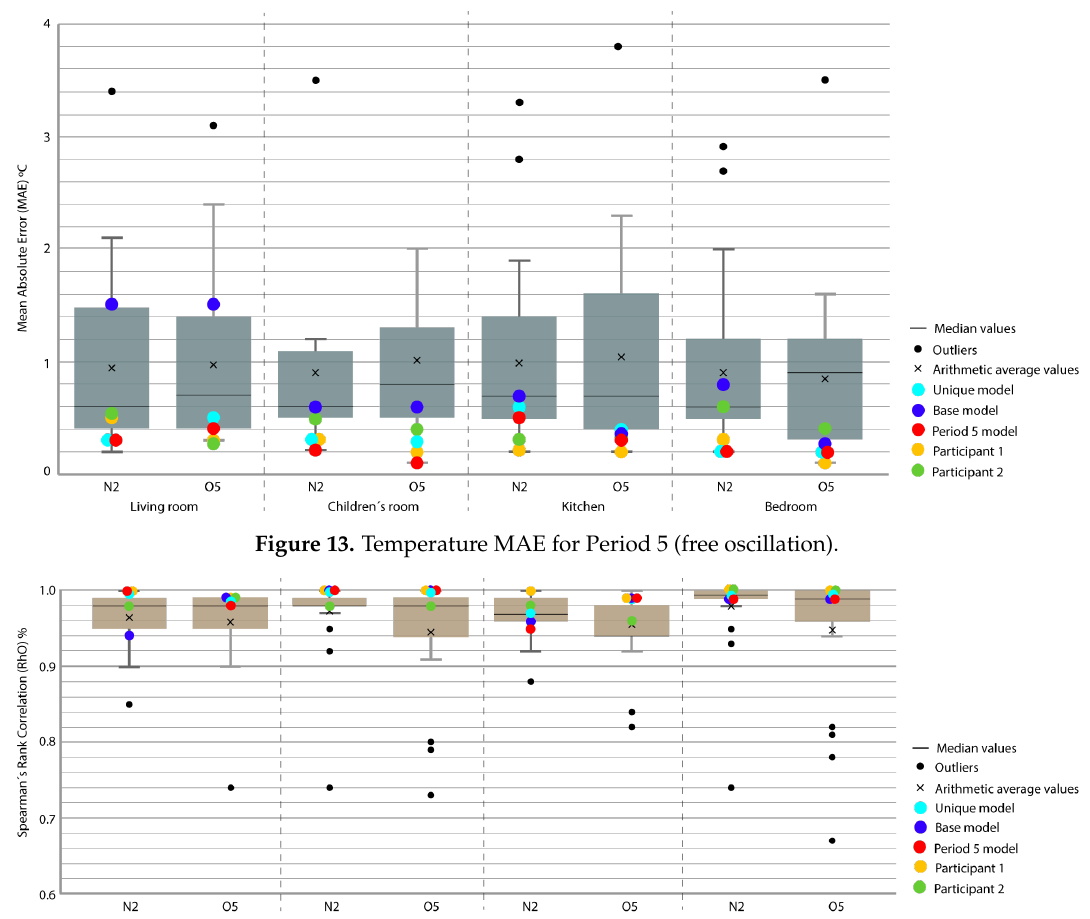
Figure 14. Temperature ρ for Period 5 (free